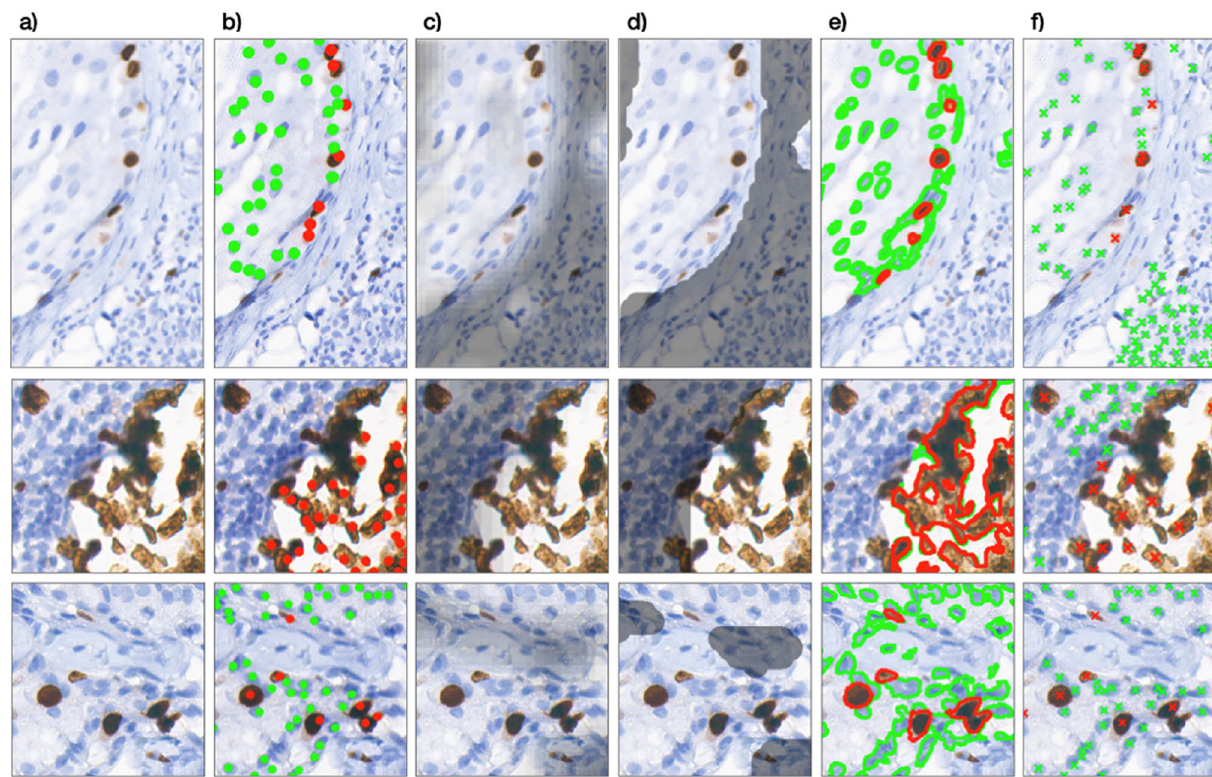
Figure 6. The method outputs overlaying the 3 source images: ( a ) is an input image ( b ) with domain expert’s annotations, ( c ) is a fuzzy output from the neural network stage, ( d ) is a binary mask being a result of the defuzzification process, ( e ) presents selected cells—immunopositive with a red outline and immunonegative with a green one, ( f ) PathoNet estimations as a reference. Our approach selects the nuclei area, while PathoNet the nuclei centers. It should be noted that our solution more accurately rejects lymphocytes and artifacts as non- tumor cells, and therefore, it approximates the proliferation index better. However, for our solution the most problematic are cells near the edges and staining blobs, which might bias the